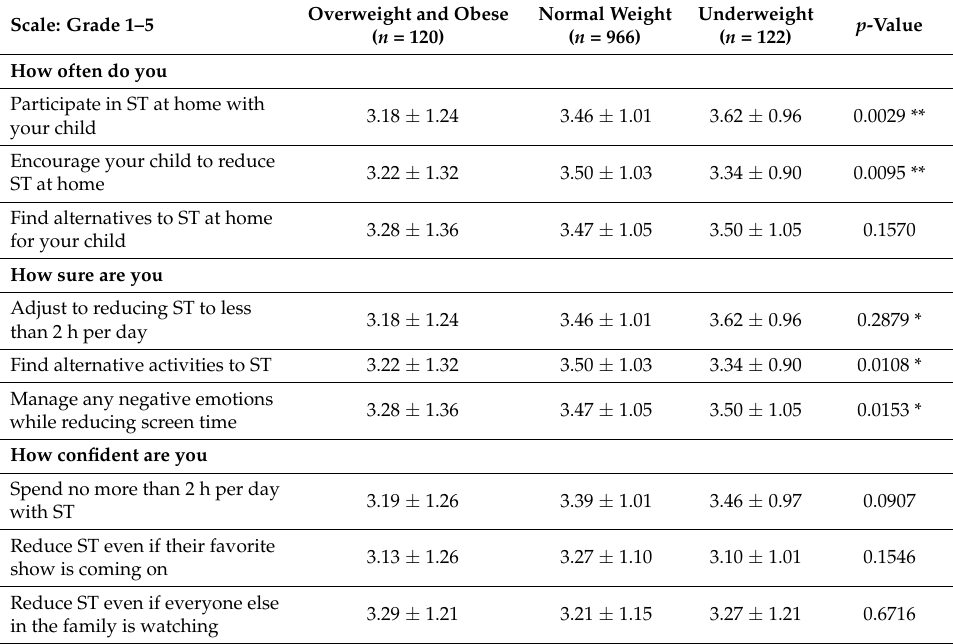
Table 5. Maternal Social Cognitive on Preschool Children’s ST behaviors by children’ weight